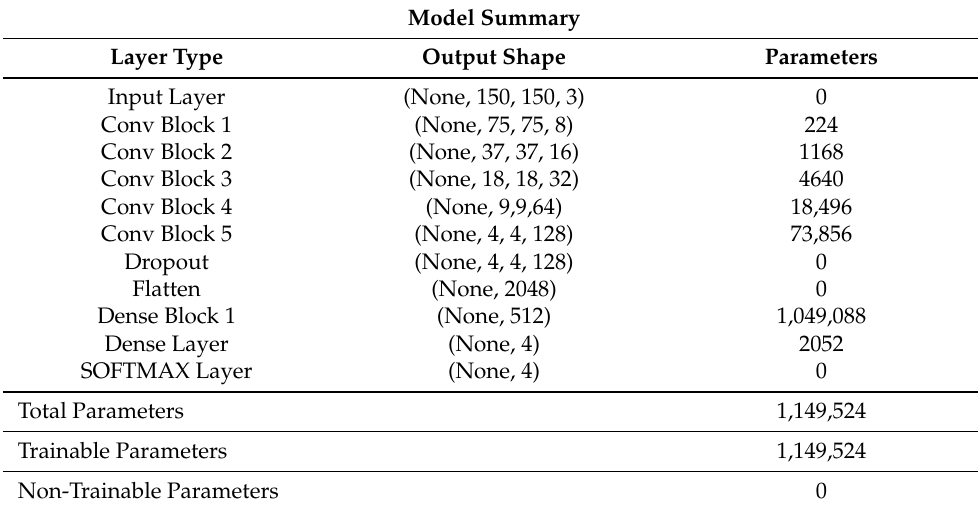
Table 2. The model summary and list of parameters used in the proposed CNN